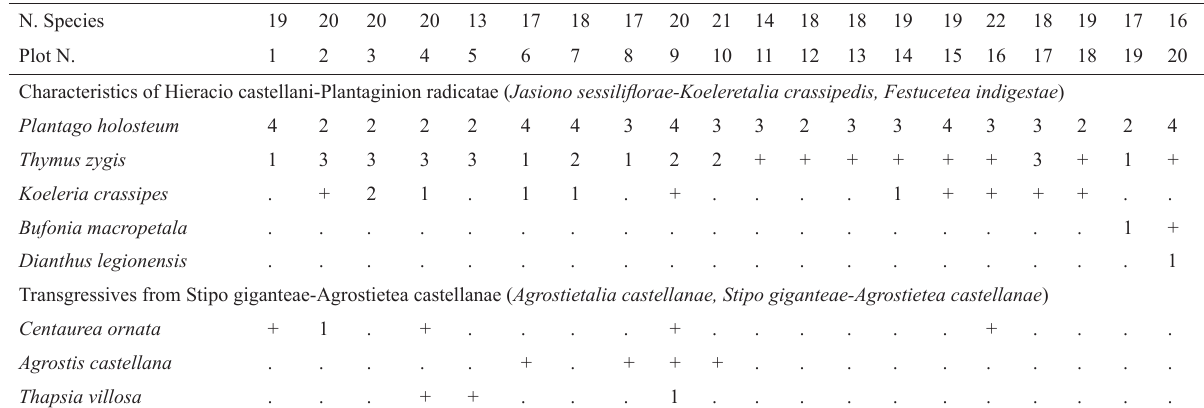
, burned). For all plots, the altitude is 1386 m asl. Indexes correspond to those B